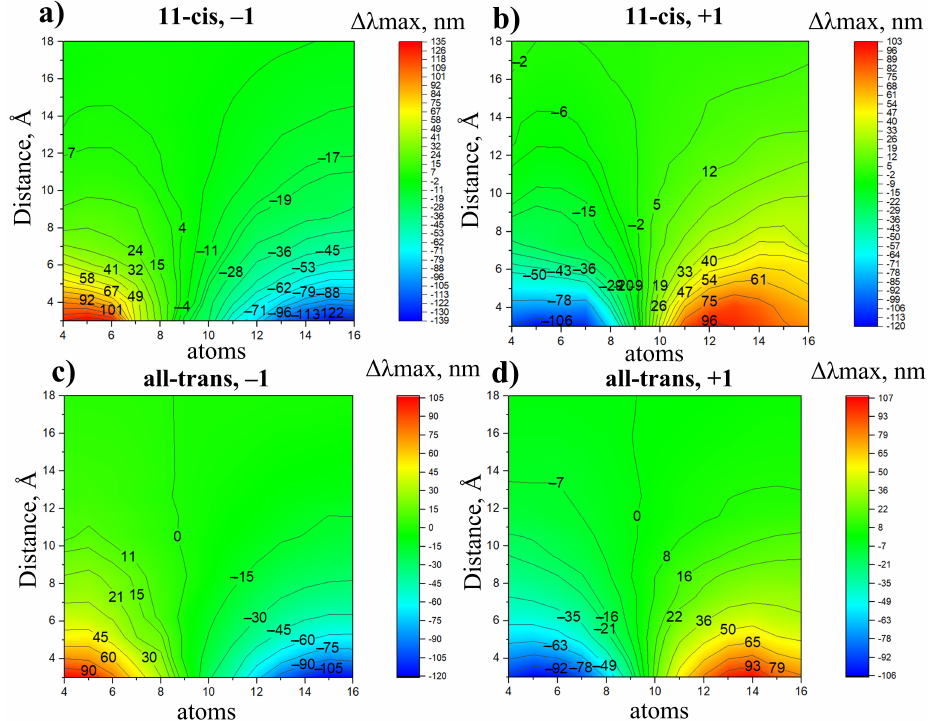
Figure 3. The impact of a unit charge on PSB λ max as a 2D function of its position relative to the chromophore. ( a ) 11-cis PSB, negative charge; ( b ) 11-cis PSB, positive charge; ( c ) all-trans PSB, negative charge; ( d ) all-trans PSB, positive